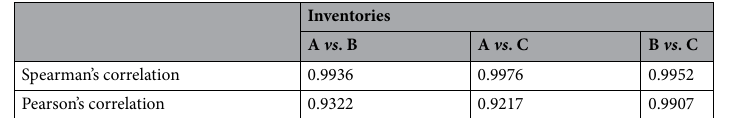
Table 6. Spearman’s and Pearson’s correlation coefficients between the three pair of LSMs from larger inventories A, B and C.